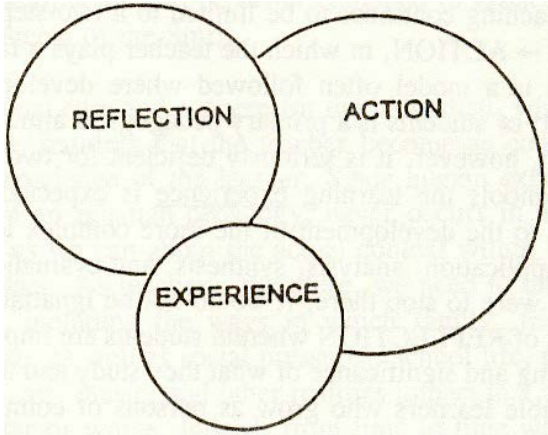
Figure 2. Ignatian